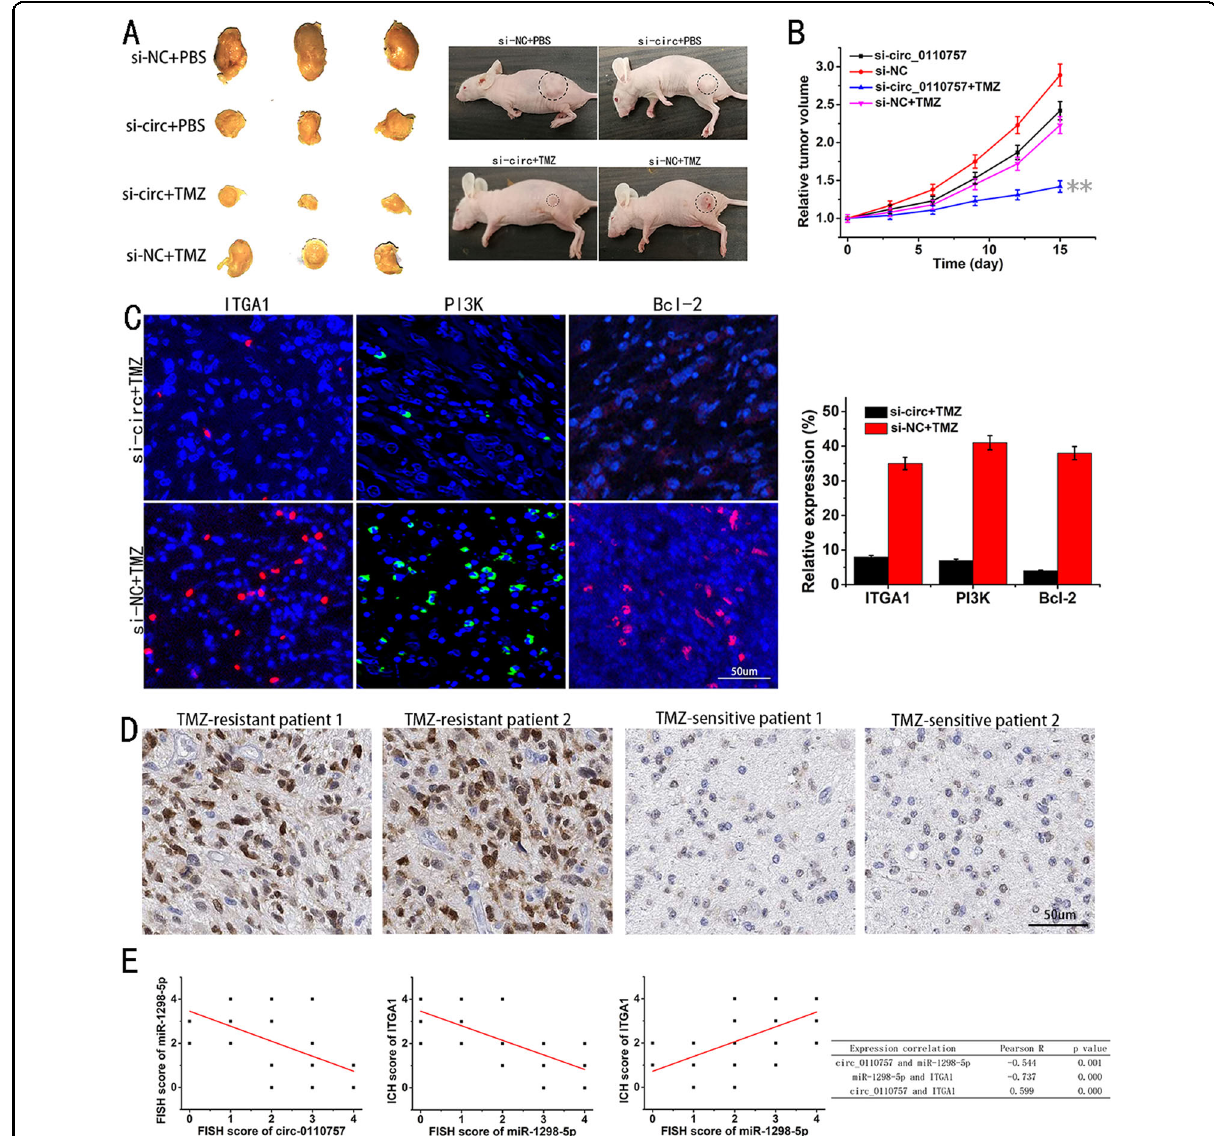
Fig. 6 Hsa_circ_0110757 facilitates TMZ resistance of glioma cells in vivo. A U87/R cell xenograft tumors of nude mice with or without hsa_circ_0110757 knockdown after TMZ application at the end of the experiment. B The relative tumor volume for 15 days. C ITGA1 (red), PI3K (green), and Bcl-2 (red) in xenograft tumors were stained by immuno fl uorescent staining. D ITGA1 in TMZ-resistant or TMZ-sensitive glioma tissues from patients were stained by Immunohistochemical staining. E Correlations between hsa_circ_0110757 and miR-1298-5p expression levels and ITGA1 protein levels in 13 TMZ-resistant and 19 TMZ-sensitive glioma patients tissues. ** P <